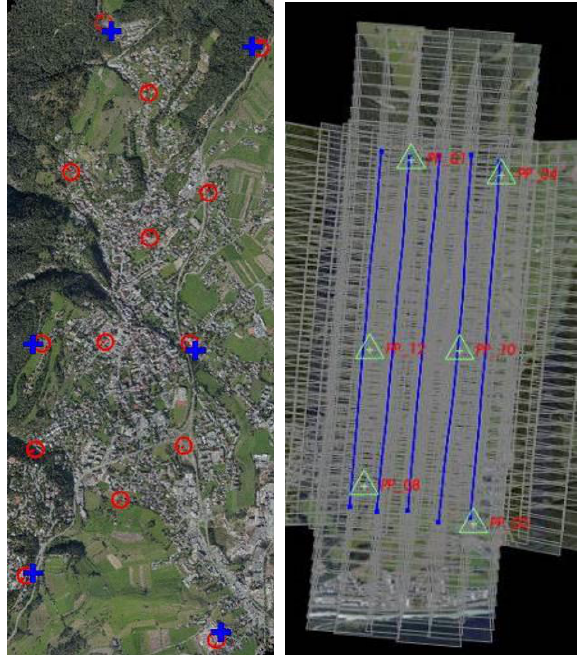
Figure 2. Imst data set. Left: location of GCPs (blue crosses) and CPs (red circles); right: flight plan (strips, GCPs and